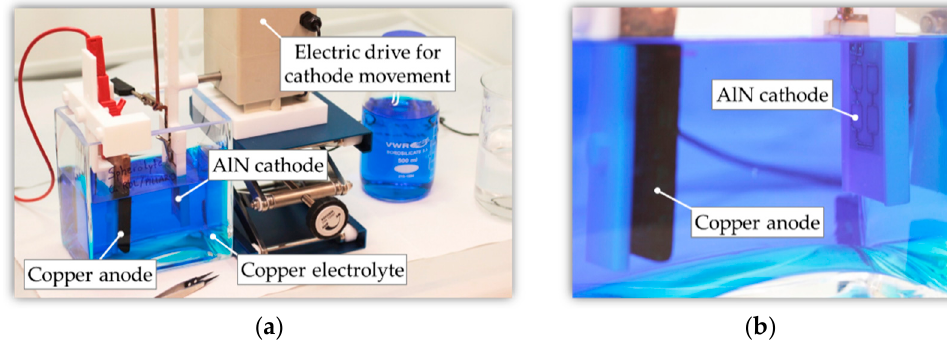
Figure 9. Copper ECD of the laser-patterned AlN substrates: ( a ) Full setup with beaker, electrolyte, anode, cathode, and electric motor; ( b ) Arrangement of copper anode and AlN cathode. The theoretical mass of the Cu layer m Cu can be determined using electrogravimetry with Faraday’s law of electrolysis (10), where M Cu is the molar mass of copper, Q is the electrical charge, z is the ionic charge, and F is the Faraday constant.